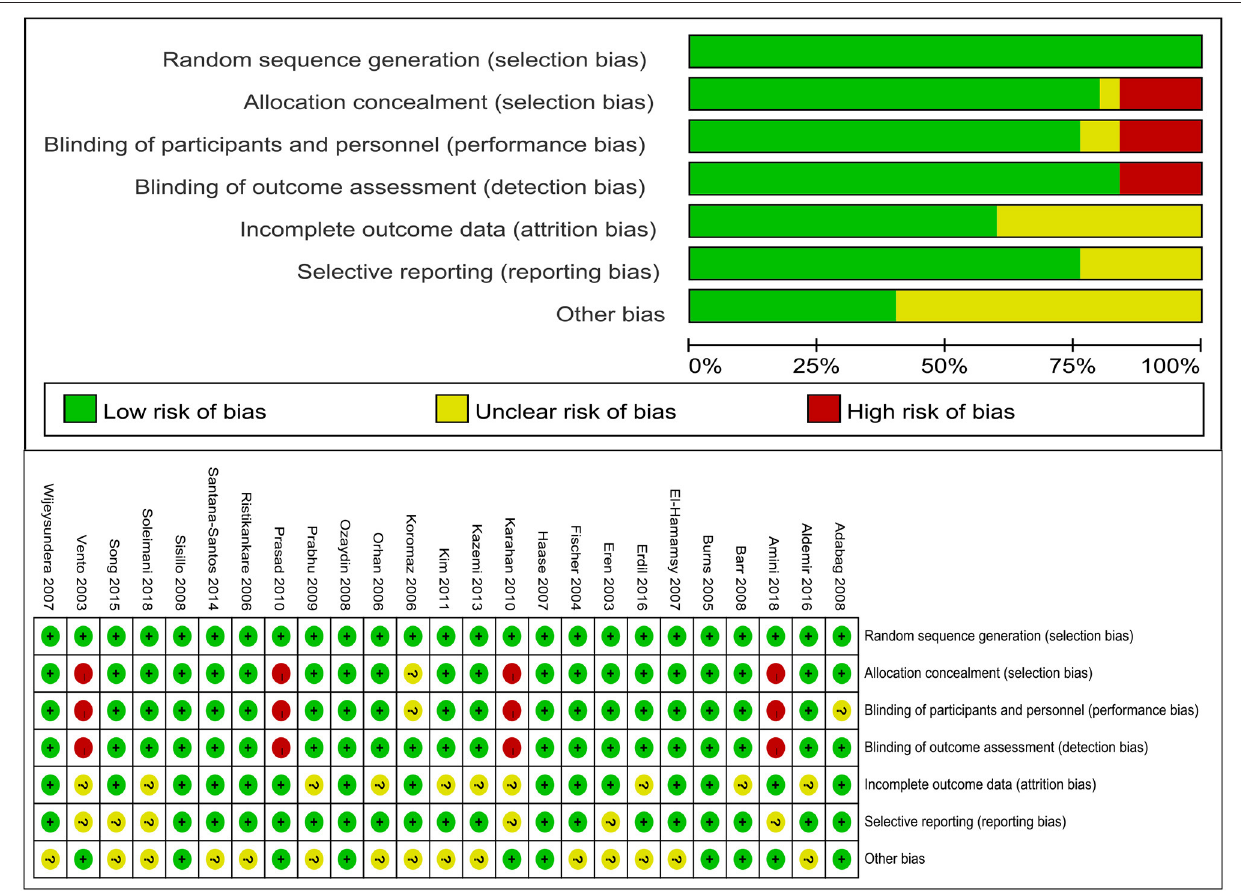
cumulative Z-curve did not cross the conventional boundary or the trial sequential monitoring boundary and did not cross the futility boundary ( Figure 3B